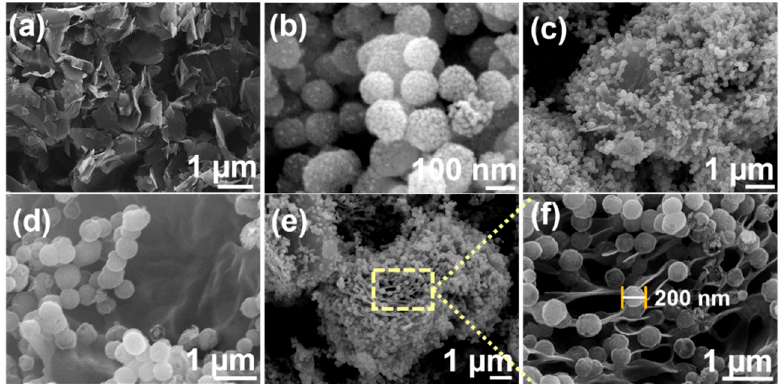
Figure 2. Scanning electron microscopy (SEM) images for ( a ) rGO flakes; ( b ) pristine CuWO 4 nanospheres; ( c – e ) CuWO 4 @rGO hybrids; and ( f ) high-resolution capture of the section showing interface formation between nanospheres and rGO edges.